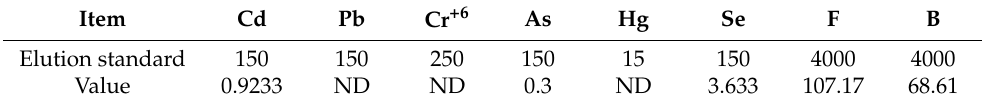
Table 12. Hazardous-substance content analysis results according to JIS K 0058 (unit: mg/kg).